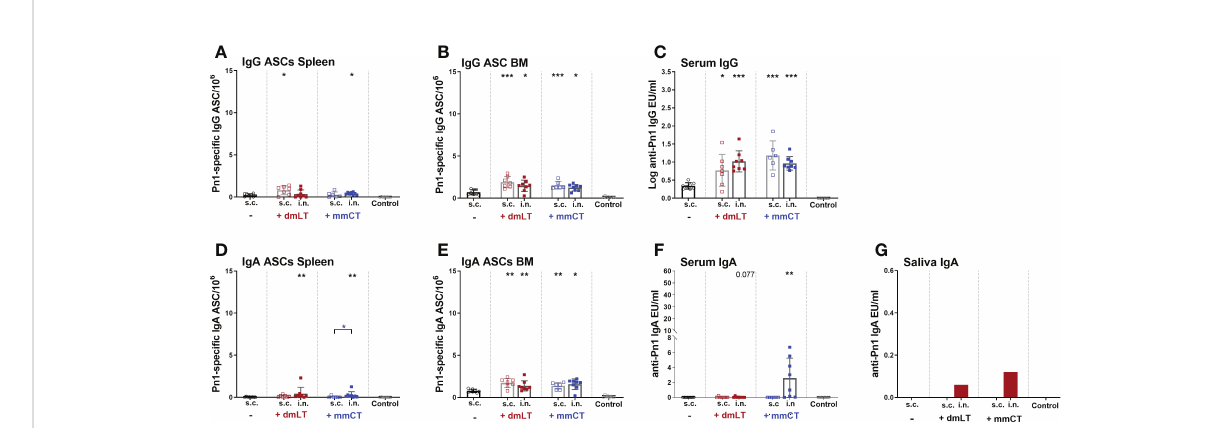
FIGURE 3 dmLT and mmCT both enhance early induction of mucosal and systemic humoral immune responses. IgG (A – C) and IgA (D – G) ASCs in spleen (A, D) and BM (B, E) and Abs in serum (C, F) and saliva (G) 14 days after immunization of neonatal mice with Pn1-CRM 197 with or without adjuvants dmLT or mmCT s.c. or i.n. Results are expressed as number of spots/10 6 cells (mean ± SD), IgG levels as (log mean EU/ml ± SD) or IgA levels (mean EU/ml ± SD) in 6 – 8 mice per group and statistical difference was calculated using Mann – Whitney U-test where adjuvant groups were compared to vaccine only group and immunization routes were compared between the adjuvanted groups. *p < 0.05, **p < 0.01,***p <